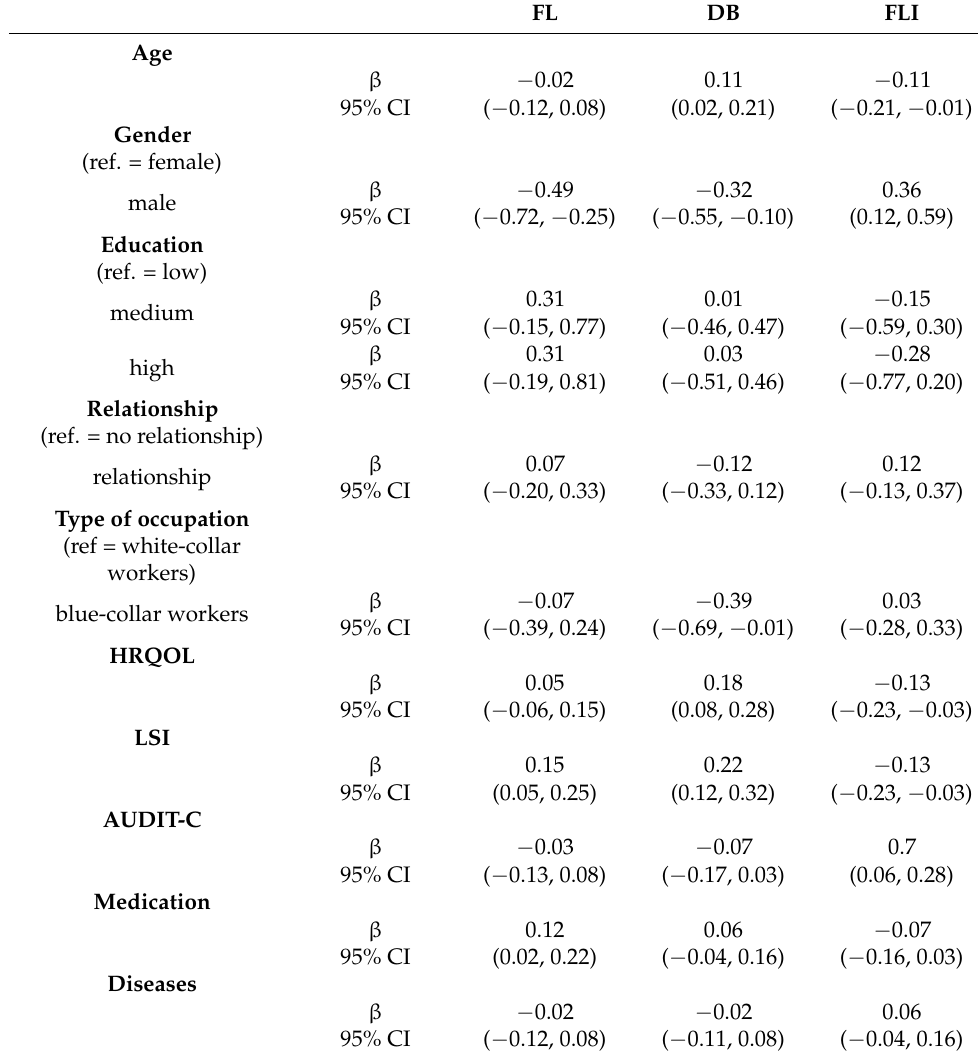
Table A2. Multiple linear regression for the control variables, FL, DB, and the